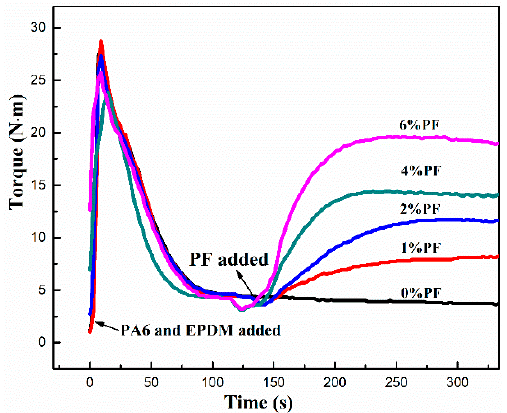
Figure 1. Plot of torque versus time during dynamic vulcanization of thermoplastic vulcanizates (TPVs) with different phenolic resin (PF) loading.